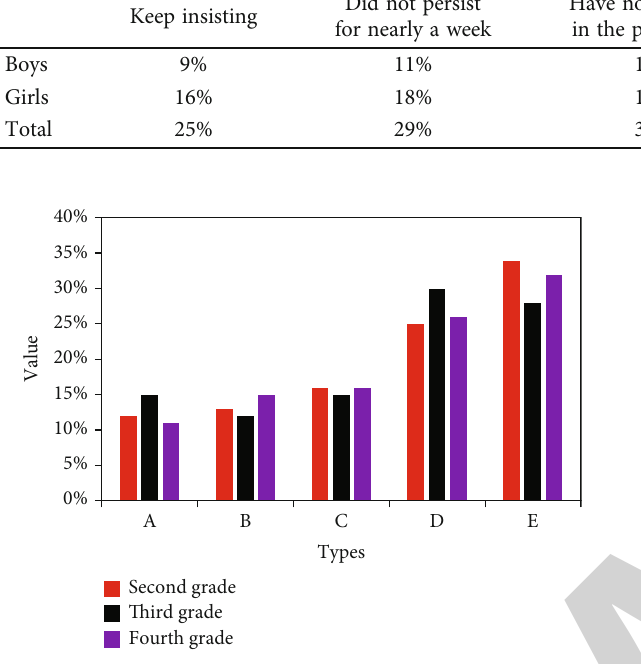
Figure 10: Physical exercise persistence in di ff erent